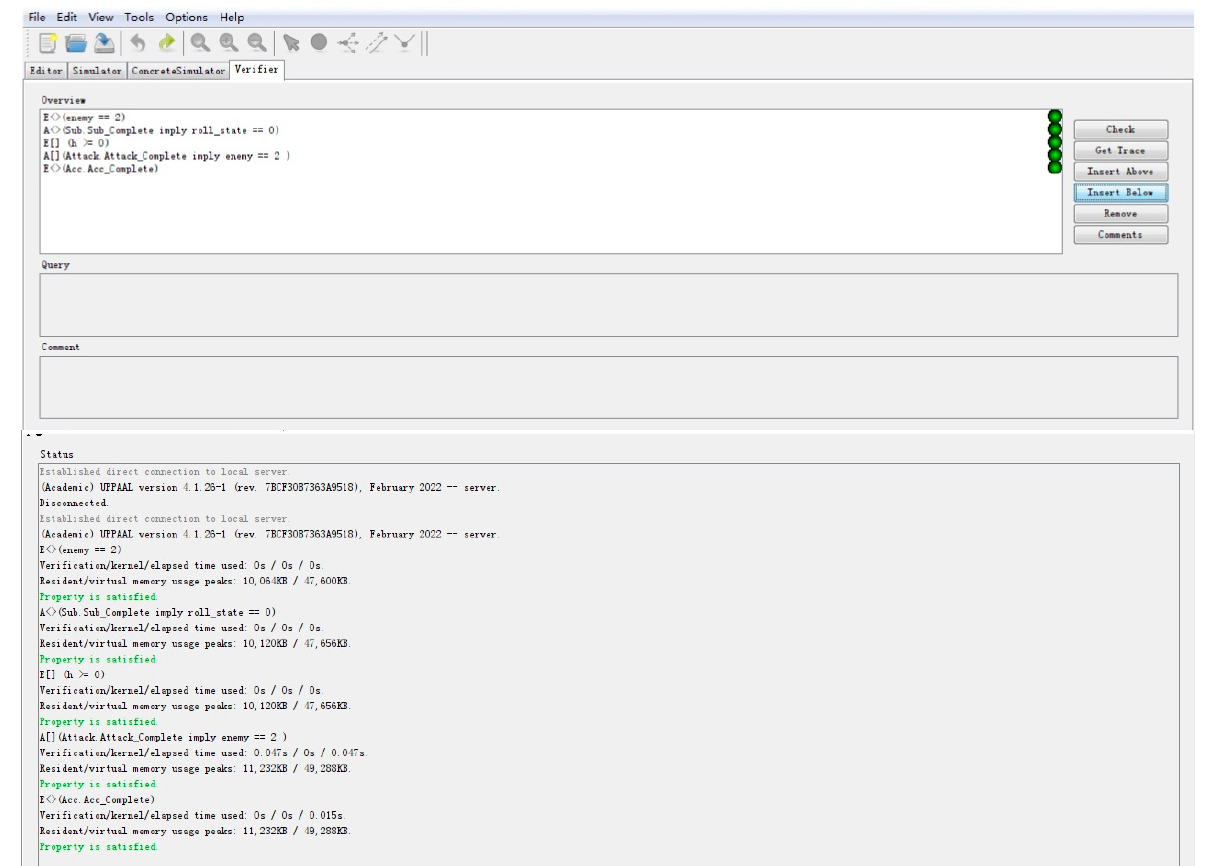
Figure 6. The validation result of the attributes of the example.